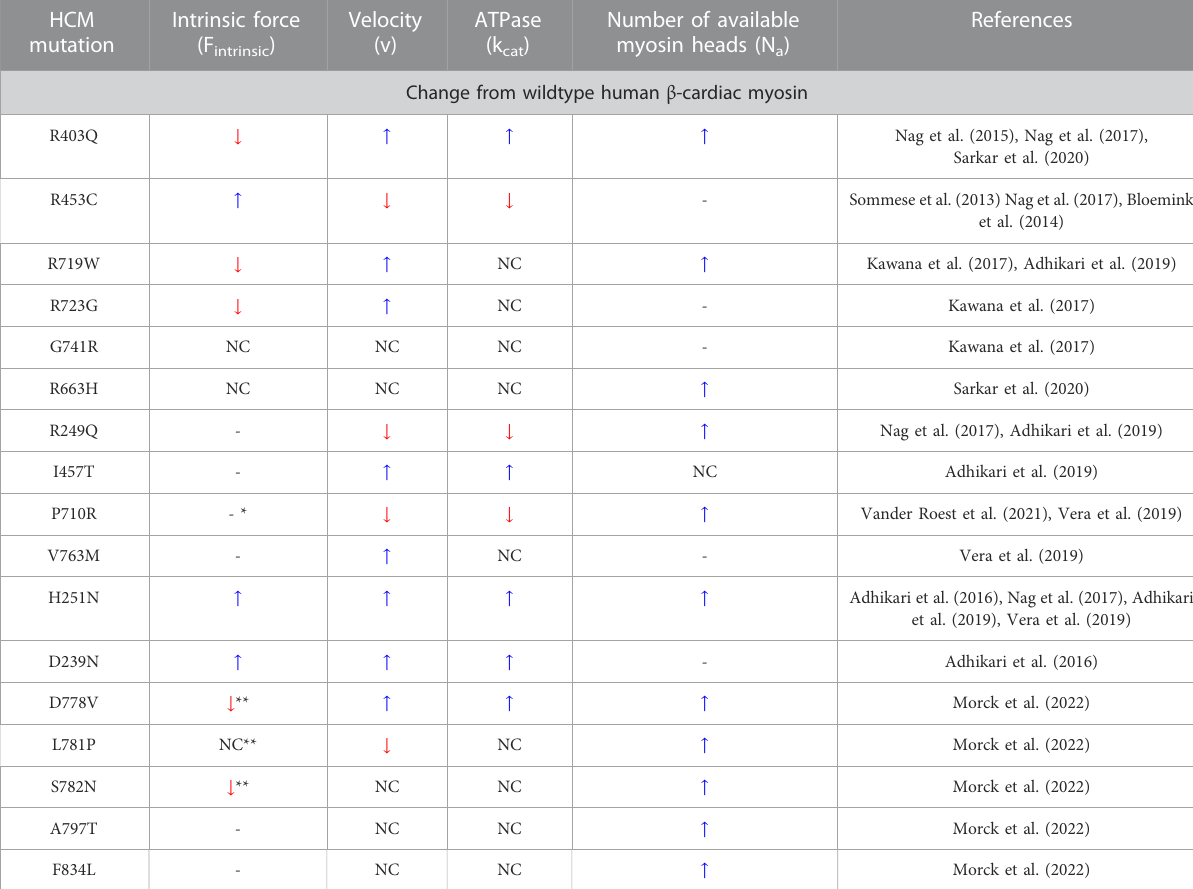
TABLE 1 Summary of the functional effect of HCM mutations in cardiac